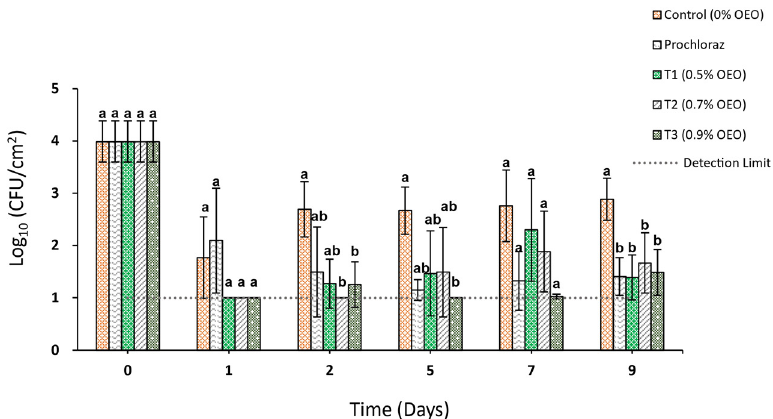
Figure 4. Populations of C. gloeosporioides on coated mango surfaces during storage at 25 °C and 90% RH. The detection limit was 1.0 log CFU/cm 2 . Error bars represent the standard errors of the means. Different letters above bars indicate significant differences in the mean for that sampling period ( p ≤ 0.05).